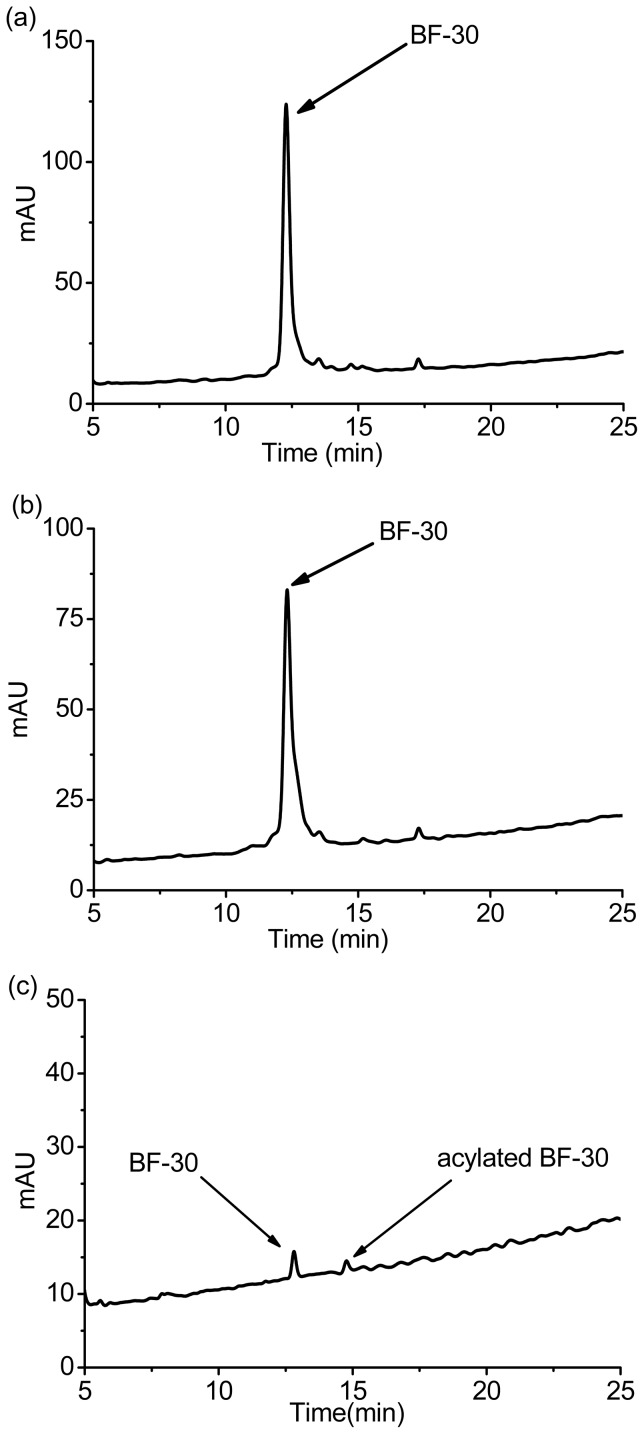
The elution curves of (a) the native BF-30 and (b) the peptide released on the 11th day, (c) the peptide released on the 10th day.